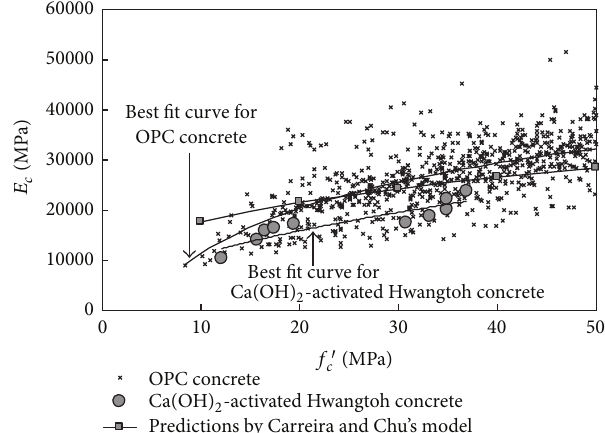
Figure 5: Modulus of elasticity ( 𝐸 𝑐 ) as a function of compressive strength ( 𝑓 󸀠 𝑐 ).